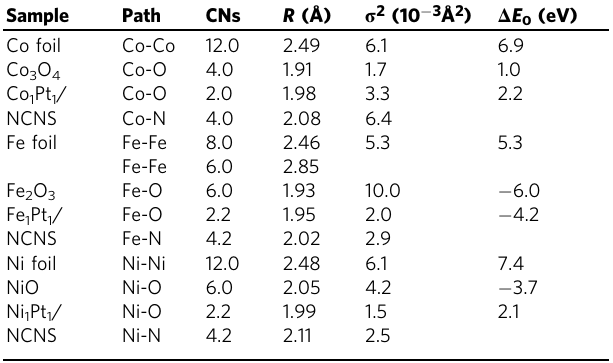
Table 1 Structural parameters of the M 1 Pt 1 /NCNS (M = Fe, Co, and Ni), foil, and oxide references extracted from quantitative EXAFS curve- fi ttings at Co, Fe, and Ni K edges.